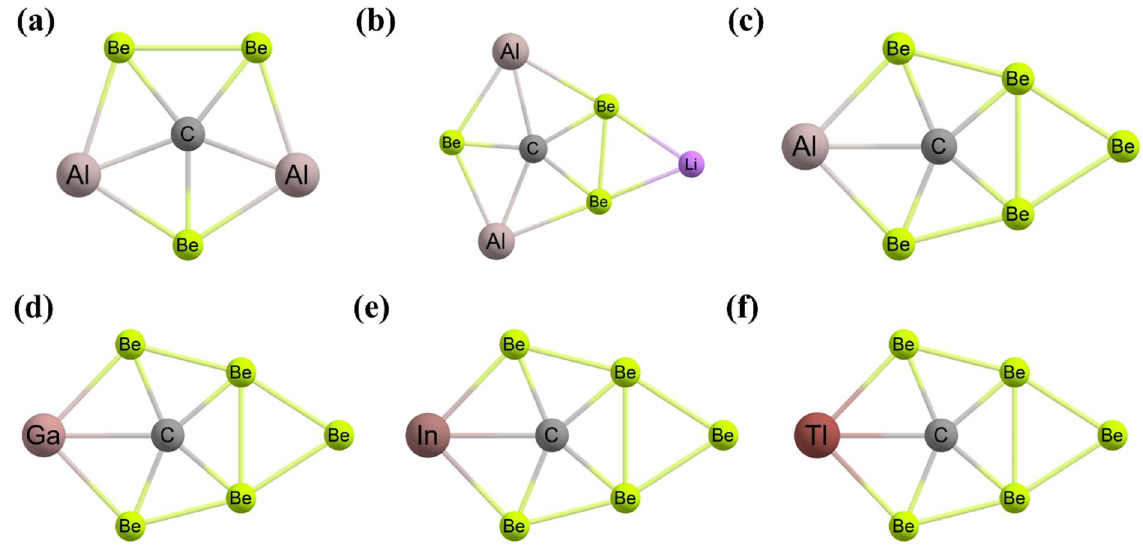
Figure 20. The global minimum energy structures of ( a ) CAl 2 Be 32 − , ( b ) LiCAl 2 Be 3 − , ( c ) CBe 5 Al − , ( d ) CBe 5 Ga − clusters. The local minimum structures of ( e ) CBe 5 In − and ( f ) CBe 5 Tl − clusters.